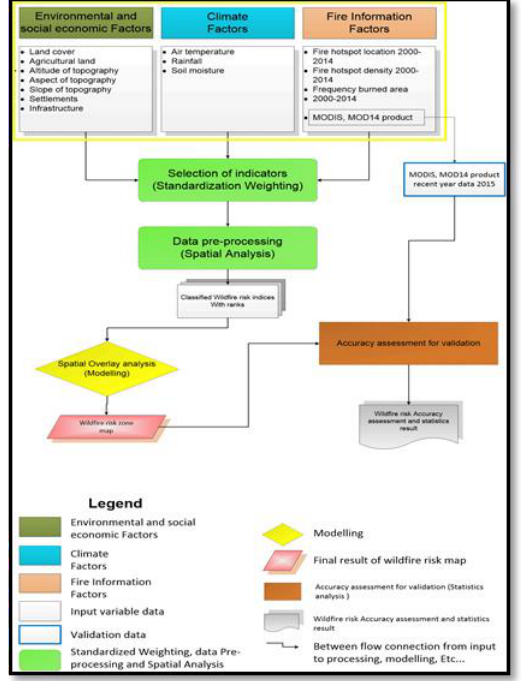
Figure 4. Flow chart of wildfire risk map MCA methods